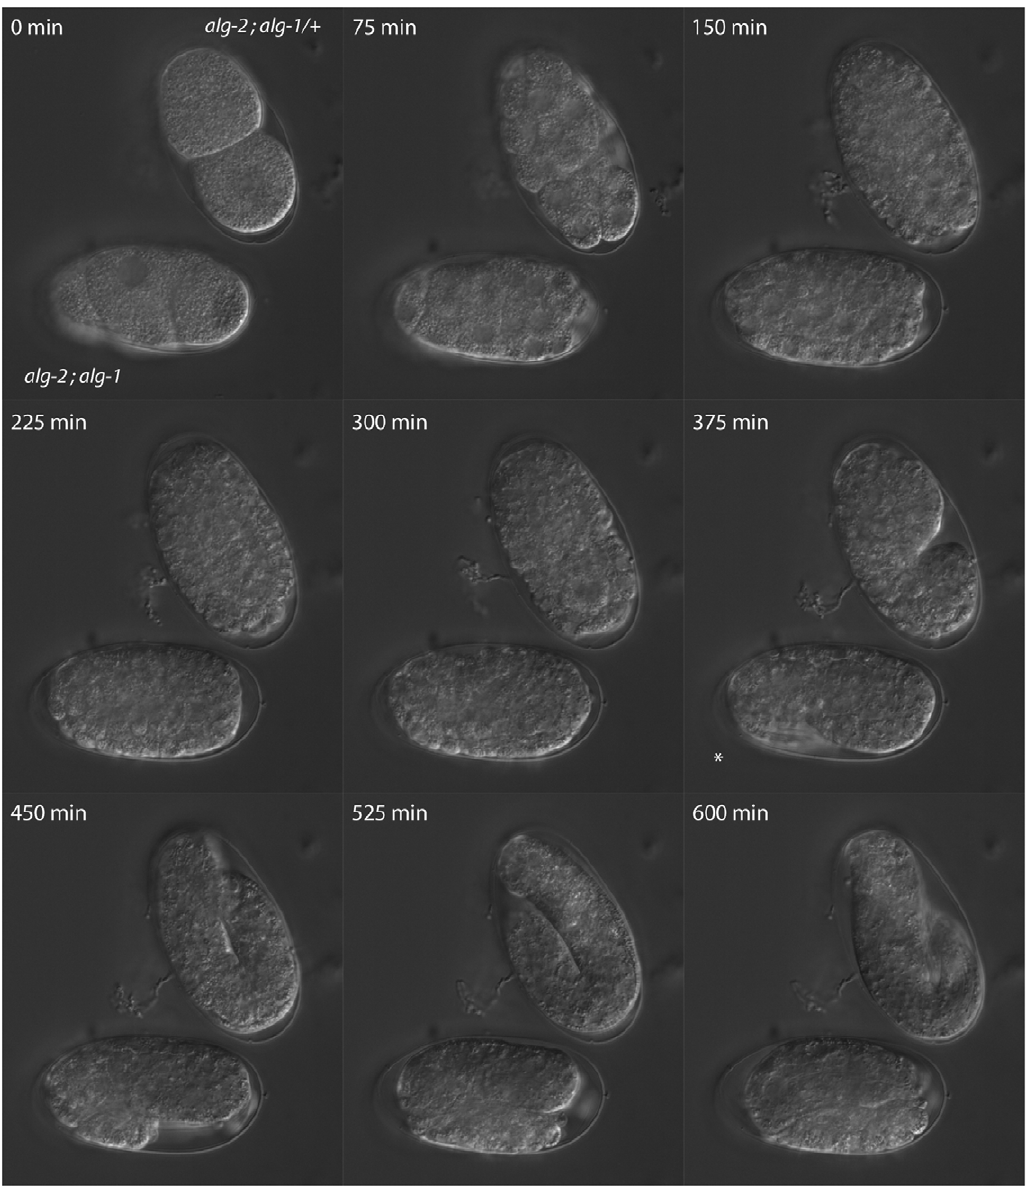
Figure 7. Developmental timing of double alg-1/2 mutant and siblings. Time-lapse microscopy of C. elegans embryos. Both embryos proceed through development at similar rates until the morphogenetic phase (375 min) were the alg-2(ok304); alg-1(gk214) double mutant arrest (asterisk). Viable siblings were able to proceed development normally. The double mutant embryos are not paralyzed and are able to twitch (see Movie S1).